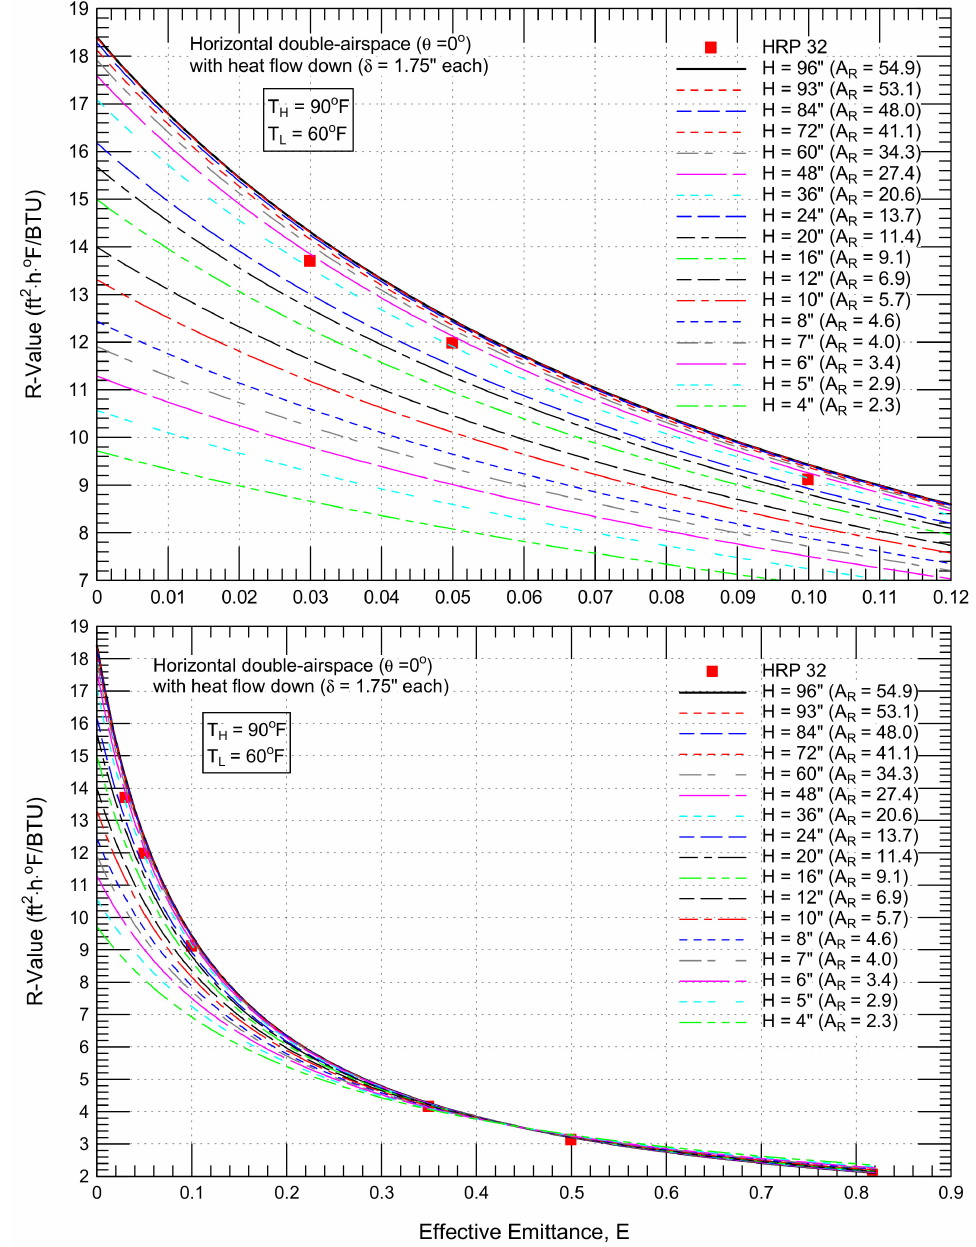
Figure 13. Comparisons of R values of HRP 32 [4] with present model predictions of various A R for double airspaces subjected to a downward heat flow ( θ = 0 ◦ , total δ = 3.5 inches, T H = 90 ◦ F, T L = 60 ◦